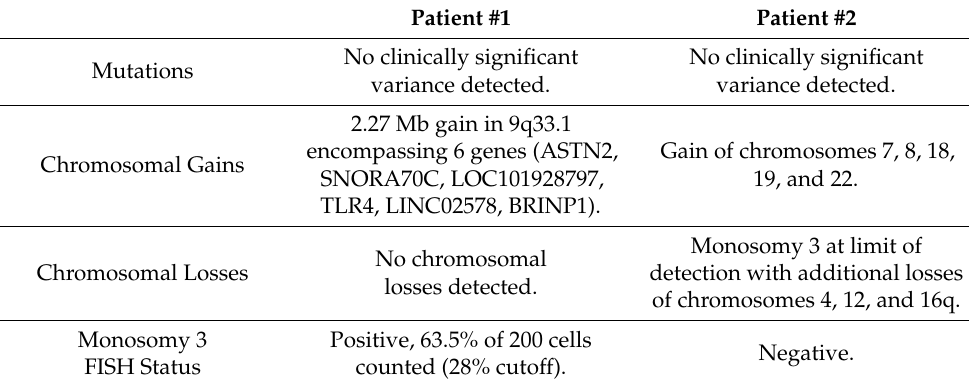
Table 1. Clinical Summary of CMA and FISH results of patient #1 and patient